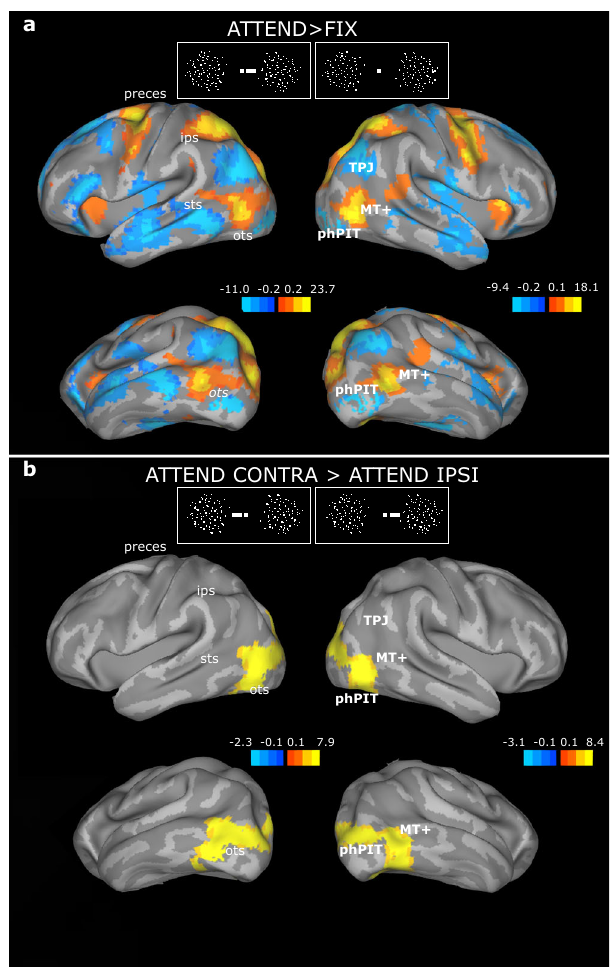
Fig. 3 Attentive motion discrimination leads to distinct activations and inactivation in occipital, temporal, parietal, and frontal lobes. a Statistical parametric maps of the contrast ‘ attention (ATTEND) vs. fi xation (FIX) ’ overlaid on the lateral and inferior views of the in fl ated average human brain. The color-bar shows T -values task-related activations (yellow/ red) and inactivation (blue). b Statistical parametric maps of the contrast ‘ attend contralaterally (CONTRA) versus ipsilaterally (IPSI) ’ . Conventions as in A. One GLM analysis was performed for the whole brain. The contrasts attention Right > Left and Left > Right are shown in the left and right column, respectively, i.e., attention contralateral > ipsilateral. The color-bar shows T -values task-related activations; for visualization purposes, a slightly different threshold is displayed for the left and right hemisphere to highlight activation similarities; the full range of the color-bars is used; dark orange shades are only visible at the edges. sts superior temporal sulcus, ips intraparietal sulcus, as arcuate sulcus, ots occipito-temporal sulcus, MT + middle temporal area, phPIT putative human Posterior Infero-Temporal area, TPJ temporo-parietal eccentricities. These results are consistent with previous fi ne retinotopic mapping of this infero-temporal region (ref. 32,35 ; see also methods section).